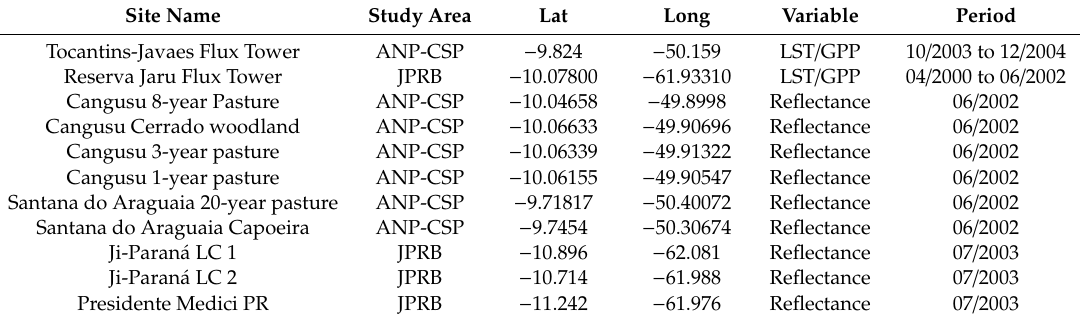
Table 1. Summary of Large-Scale Biosphere-Atmosphere (LBA) data for the study areas: Araguaia National Park and Cant ã o State Park (ANP-CSP) and Ji-Paran á River Basin (JPRB). The variables used were Land-Surface Temperature (LST), Gross Primary Productivity (GPP), and reflectance.